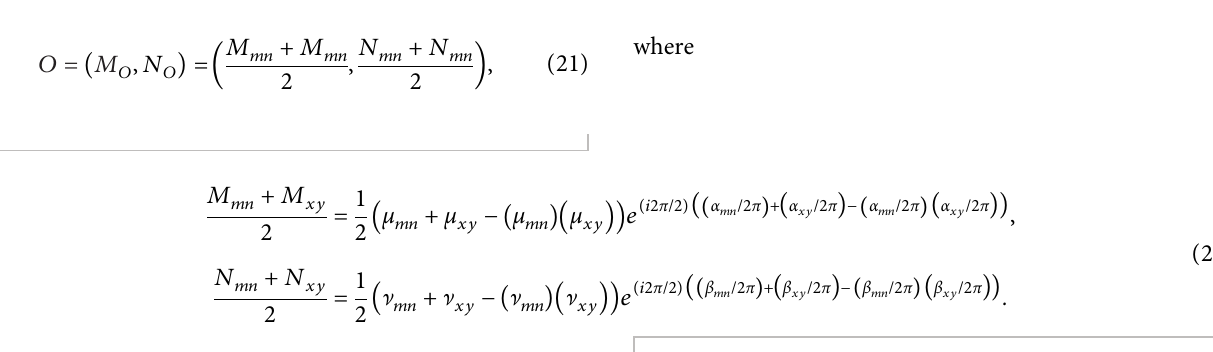
Figure 3: Complex q-rung orthopair fuzzy